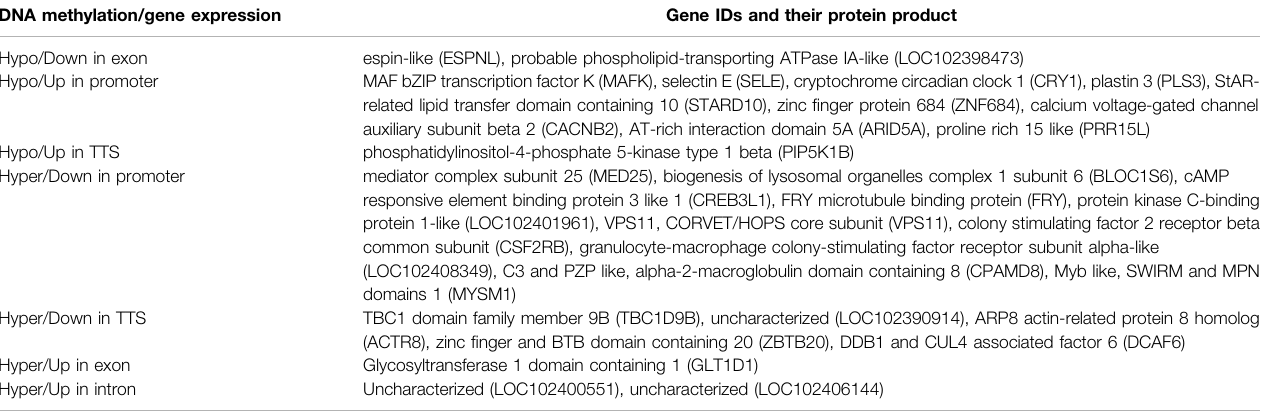
TABLE 2 | Coordinated relation of DMGs with DNA methylation and gene expression according to genomic regions. DNA methylation/gene expression Gene IDs and their protein product